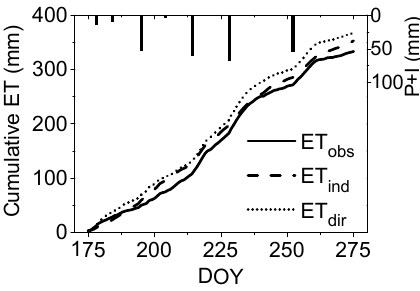
Figure 9. Cumulative variation in observed ET and simulated ET (as deducted from the two ET simulation